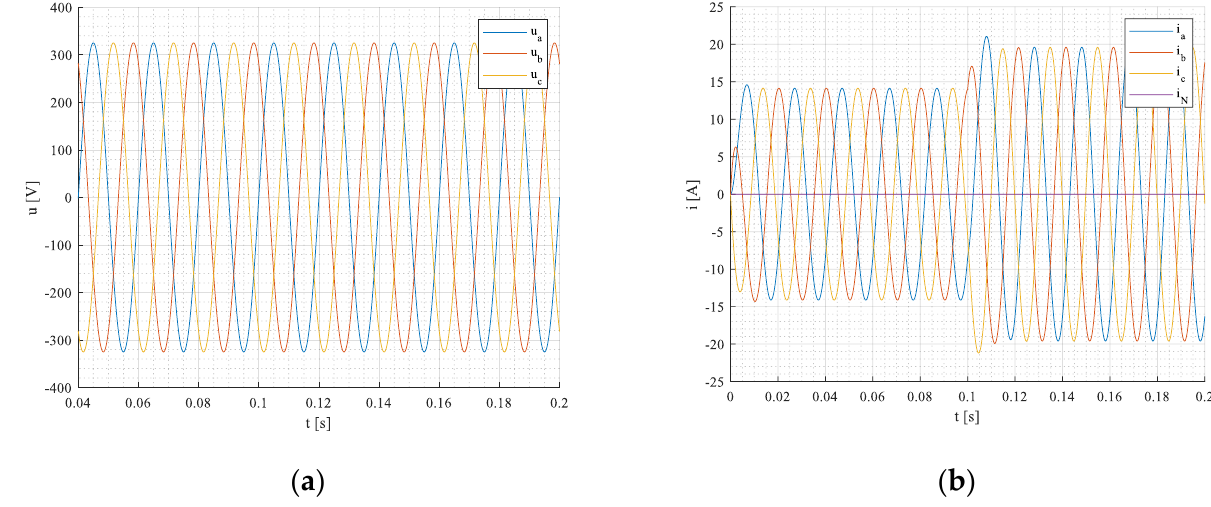
Figure 6. Phase voltages ( a ), currents ( b ) in 𝑎, 𝑏, 𝑐 — coordinates. Apparent, active, blind, and distortion powers during transient states are shown, due to comparison to 5- and 2-phase systems, at the end of Section 3.1. 3-Phase Network and Active Load—3-Phase IM Motor Parameters of the 3-phase 4-pole IM motor at t ∈ (cid:104) 0.2; 0.4 (cid:105) and t ∈ (cid:104) 0.4; 0.6 (cid:105) are given in Table